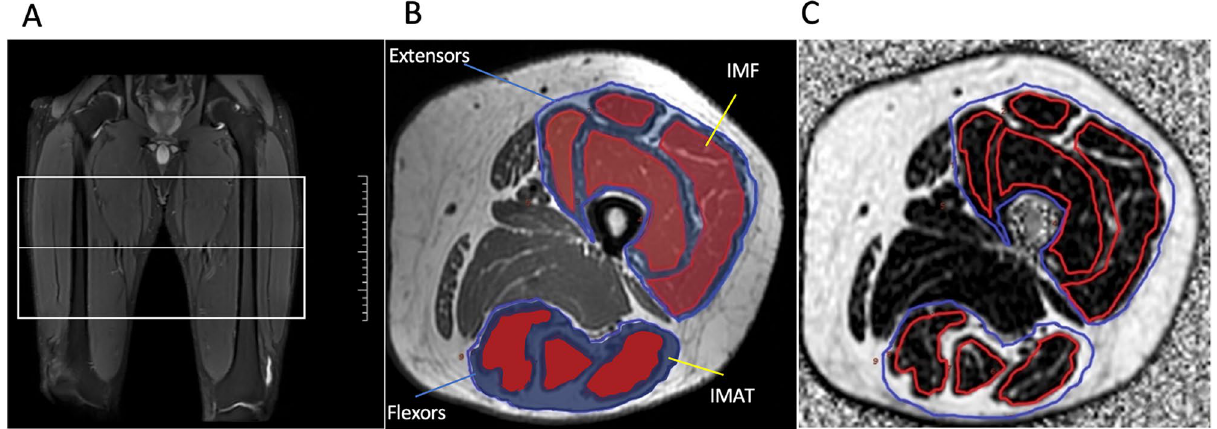
Figure 1. Magnetic resonance image scanning and muscles MRI ROI delineation. ( A ) MRI scanning range of the thigh (white box). ( B ) Axial T1WI showing segmentation of thigh muscle and fat. IMF, intramuscular fat; IMAT, intermuscular adipose tissue. ( C ) PDFF maps of left thigh muscle.